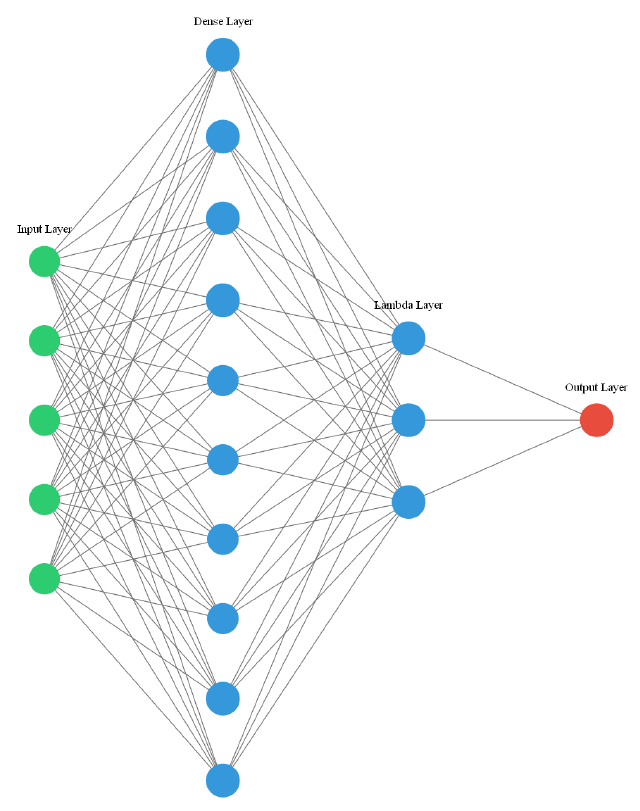
Figure 1. Structure diagram of a neural network (NN).